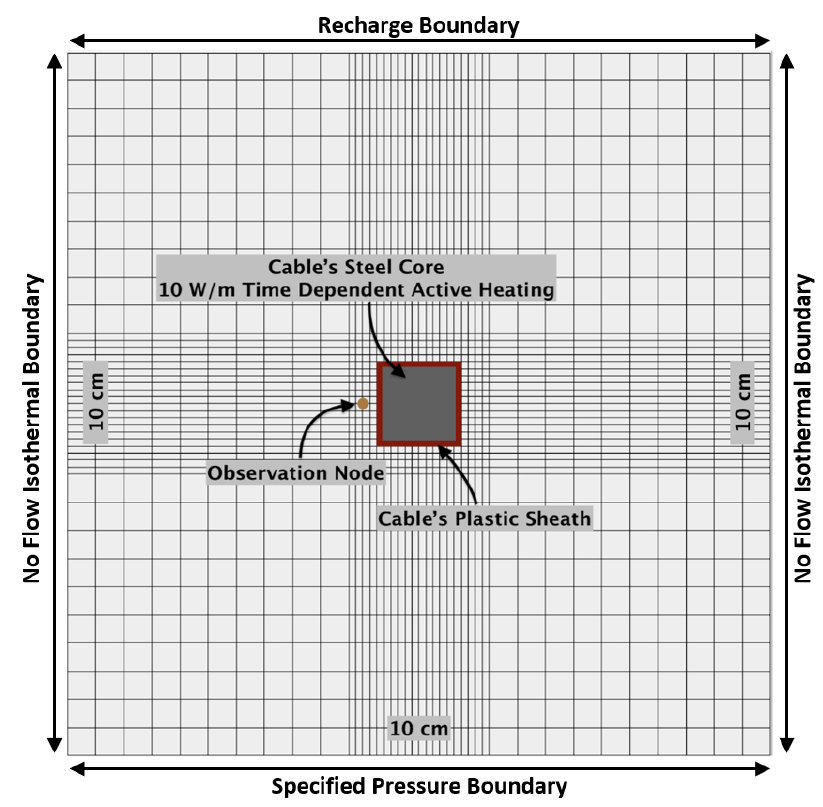
Figure 1. Model domain. The domain is 0.10 m × 0.10 m and contains 0.004 m × 0.004 m elements and 0.001 m × 0.001 m elements in the outer and center areas, respectively. The model domain includes the cable plastic sheath and steel core. Soil moisture is recorded at the observation node. Table 1. Base model parameters.